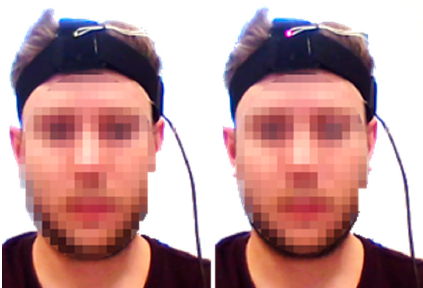
Figure 9. The LED Indicator used for synchronisation between two tracking systems. Left : Off, Right : On.